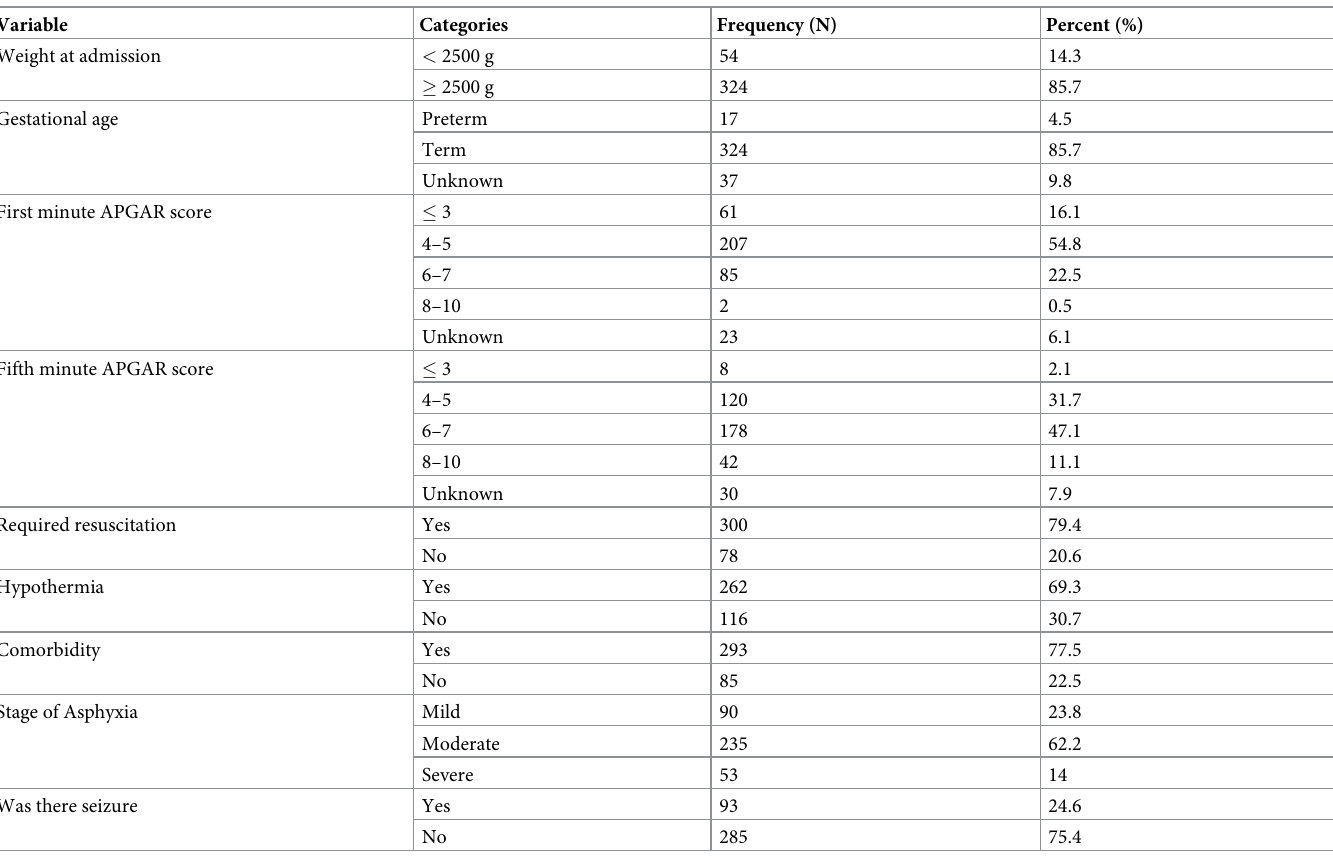
Table 3. Newborn health related characteristics of the study subjects in DCSH, Amhara region, Northeast Ethiopia (N = 378).